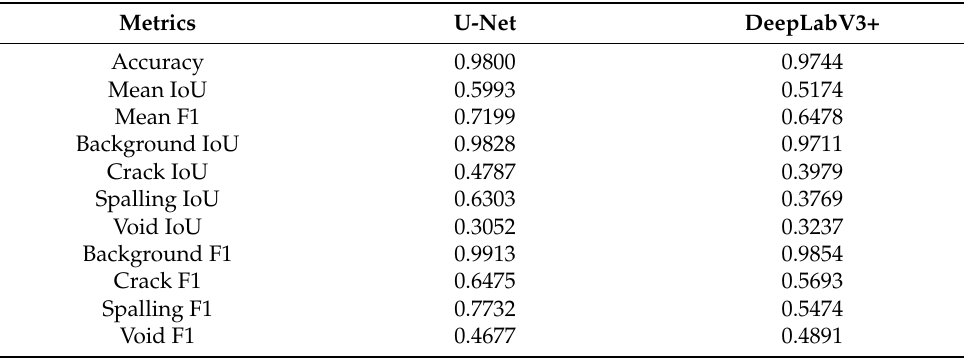
Table 1. U-Net and DeepLabV3+ training results